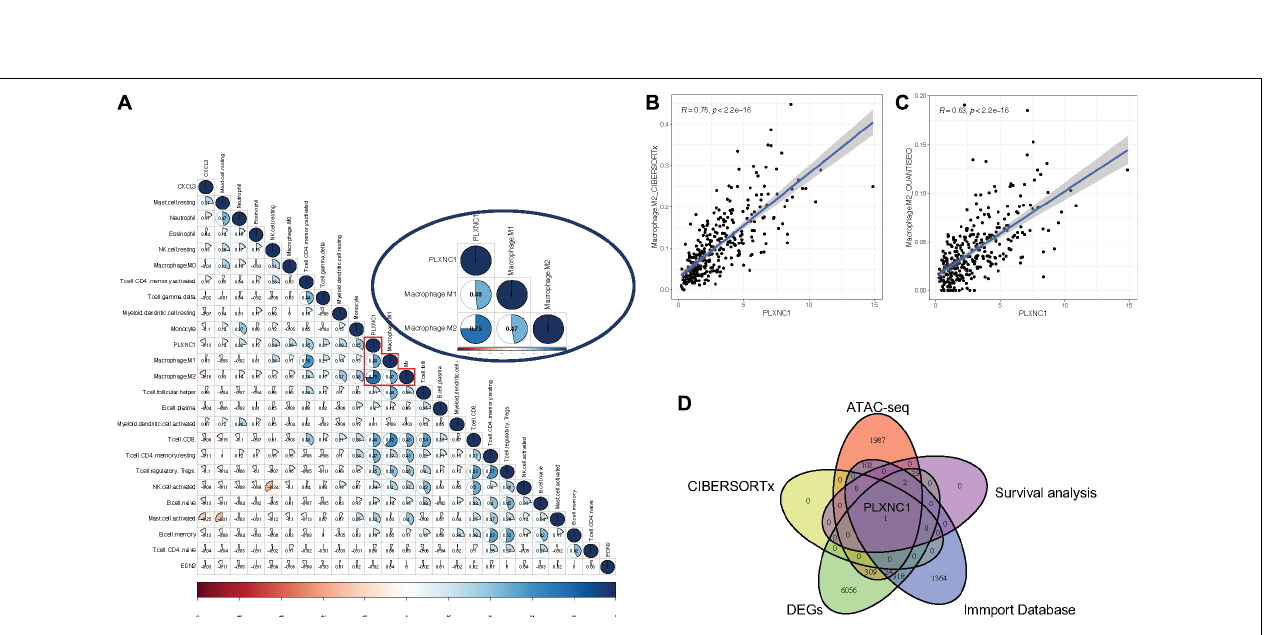
Frontiers in Cell and Developmental Biology |